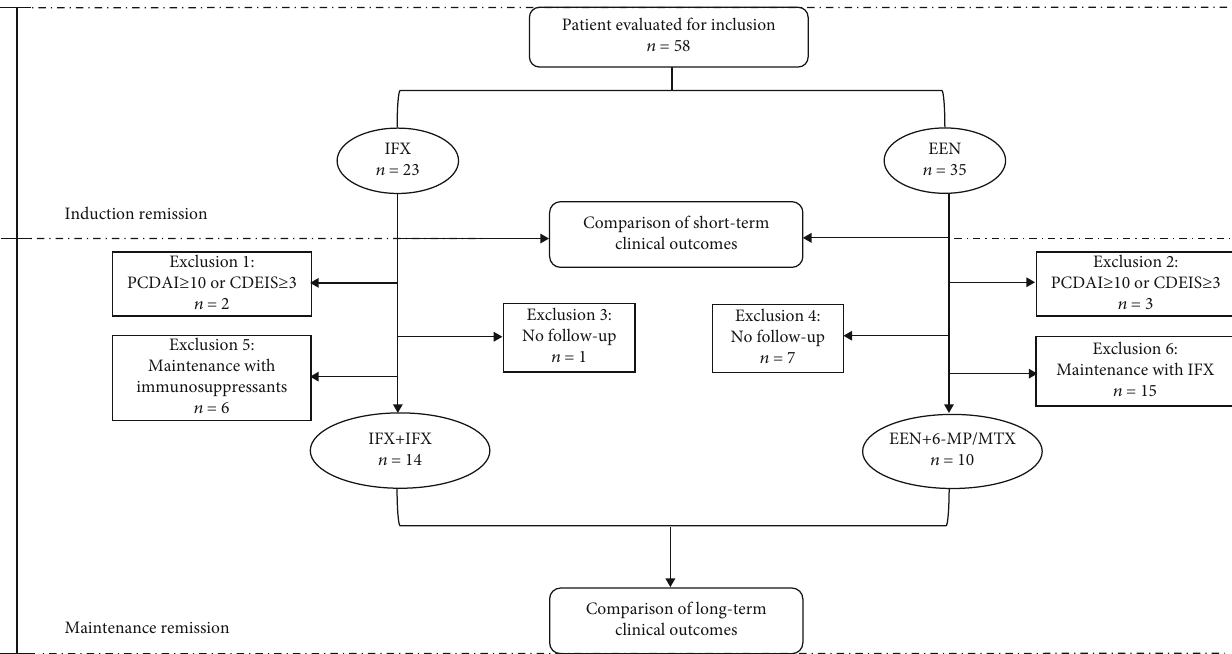
Figure 2: Study outline and patient selection. IFX+IFX: IFX was used as monotherapy during both the period of induction and maintenance; EEN+6-MP/MTX: EEN was used as induction therapy, and 6-MP/MTX was used as monotherapy during maintenance